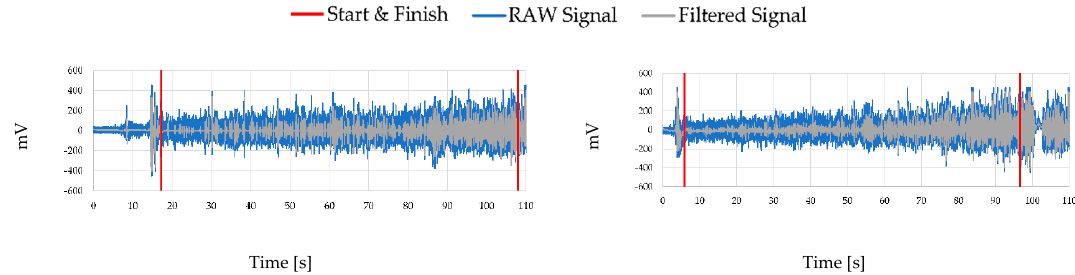
Figure 4. Example of the raw electromyography (EMG) signal amplitude (mV) captured in the experiment across time (s), where it can be observed how the amplitude increases in time. The example on the bottom comes from a female who is 24 years old, exercises 3 h a week and has a BMI of 24, and the example on top comes from a male who is 23 years old, exercises 3 h a week and has a BMI of 23.6.